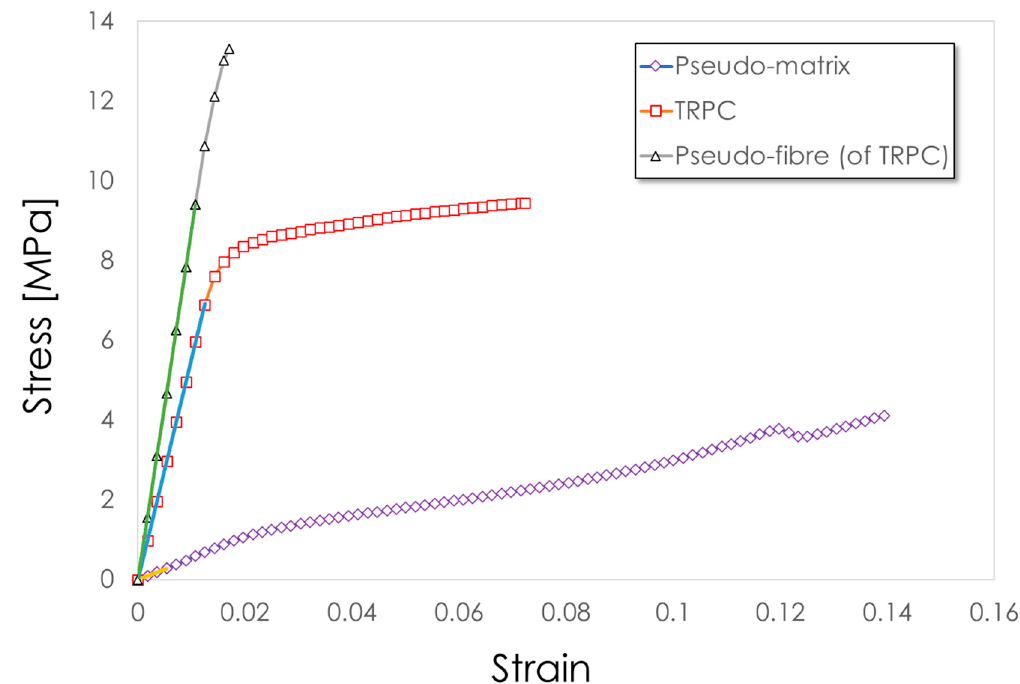
Figure 4. Engineering stress-strain plots for TRPC in tension, pseudo-matrix in tension, and TRPC pseudo-fibre in tension.